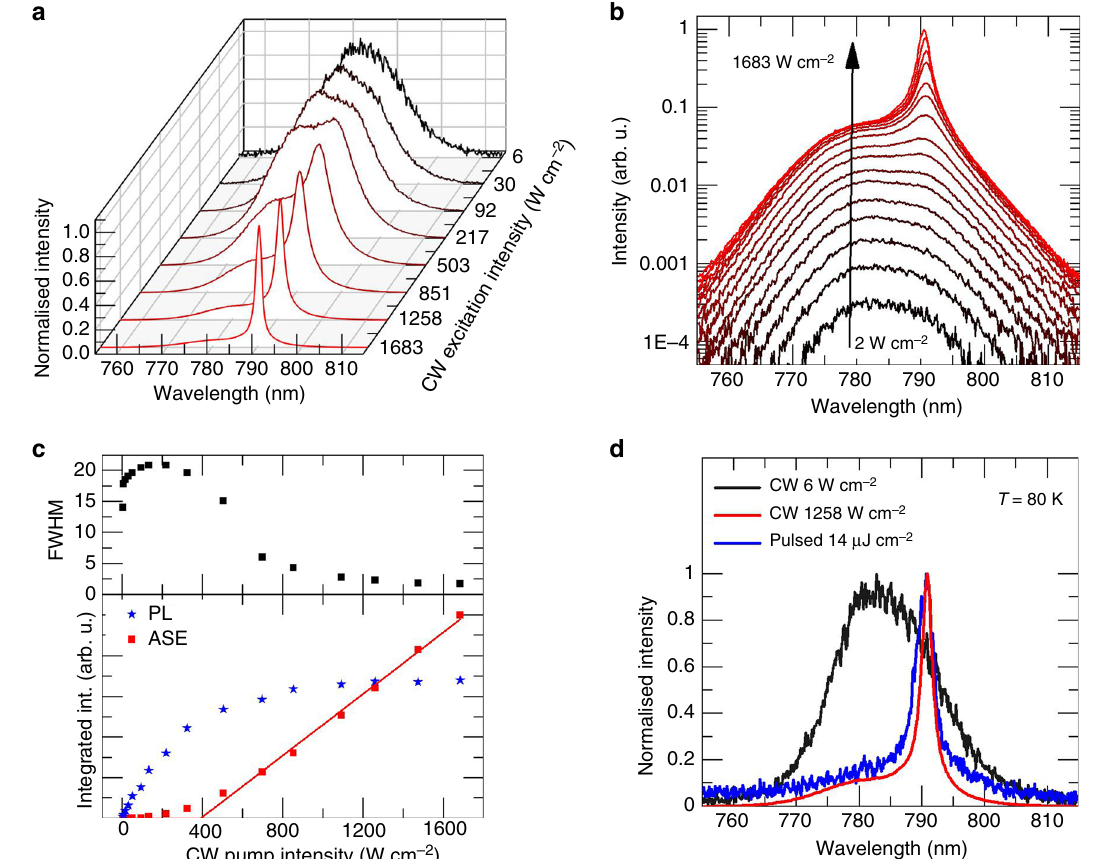
Fig. 3 Characterization of CW ASE at 80 K. a The emission spectrum changes for increasing excitation intensities from a broadband PL spectrum (FWHM~15 – 20 nm) to a narrowband ASE spectrum (FWHM ~2 nm). b Logarithmic representation of the luminescence spectra for increasing excitation intensities showing the rise of ASE between 786 and 794 nm. c PL, ASE, and FWHM as a function of the CW excitation intensity. At the threshold intensity of 387 W cm − 2 , the FWHM decreases signi fi cantly and most of the additional pump intensity is fed into the ASE band. d Comparison of CW PL, CW ASE, and pulsed ASE spectra at 80 K